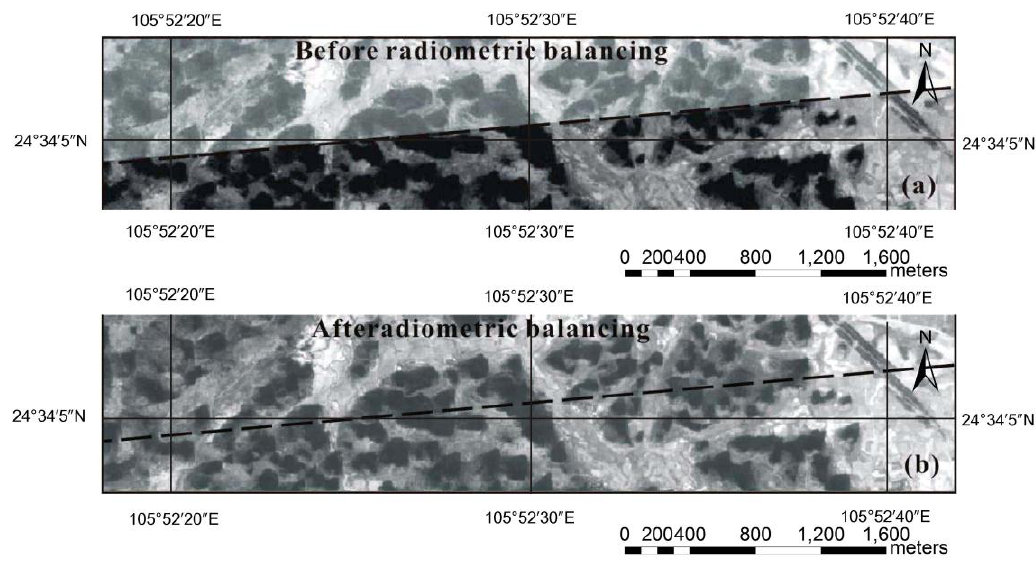
Figure 11. Radiometric balance of neighboring strips: ( a ) The image before radiometric balancing; ( b ) The image after radiometric balancing.